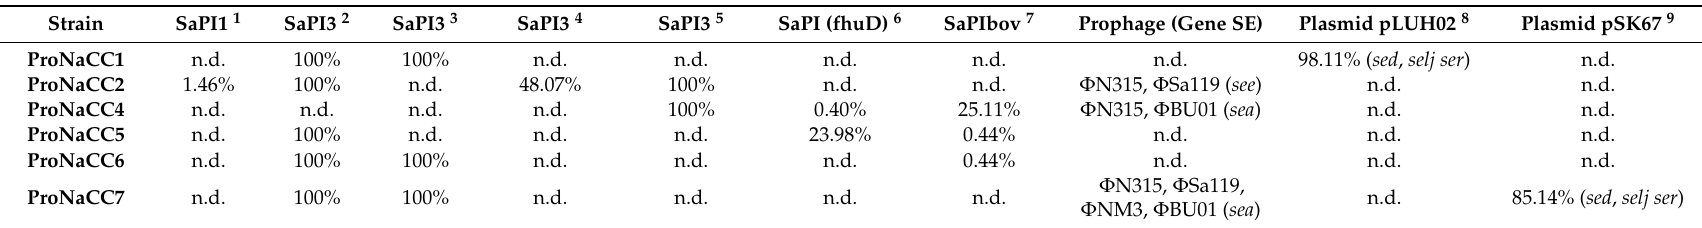
Table 7. Detection of mobile genetic elements and the presence of staphylococcal enterotoxins genes and percentage of coverage to the reference sequences.